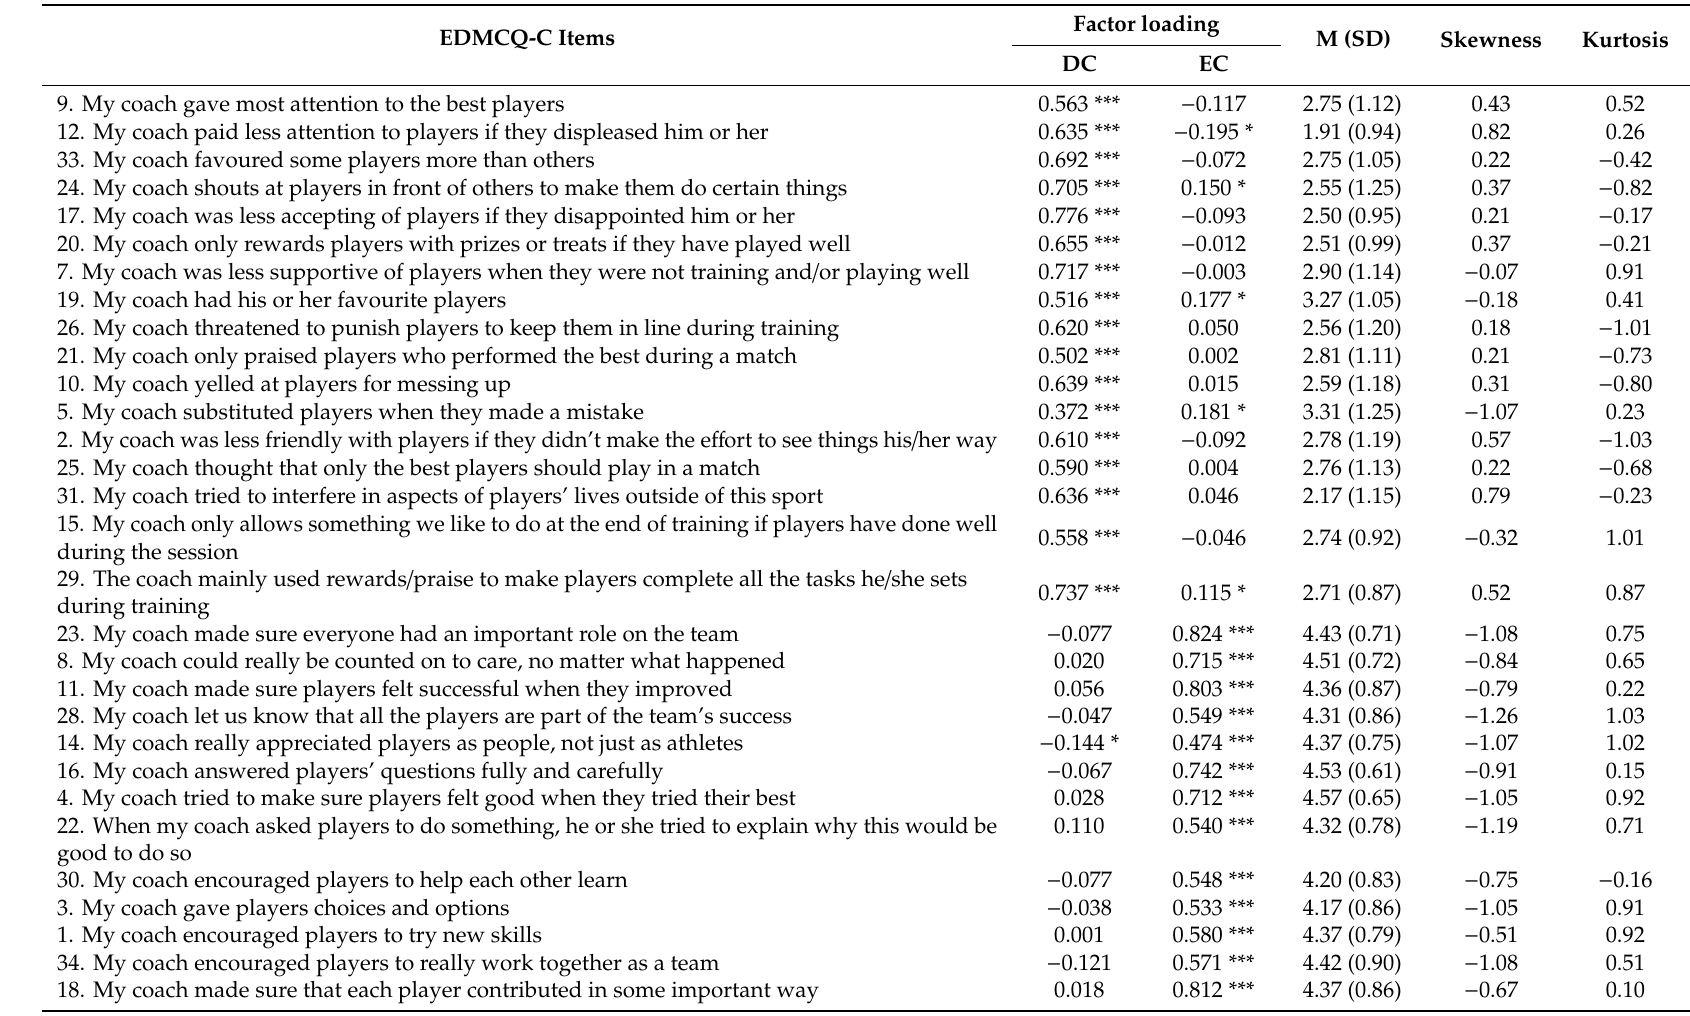
Table 2. Items, standardized factor loadings (FL) for Empowering and Disempowering Motivational Climate Questionnaire-Coach (EDMCQ-C) (group two). EDMCQ-C Items